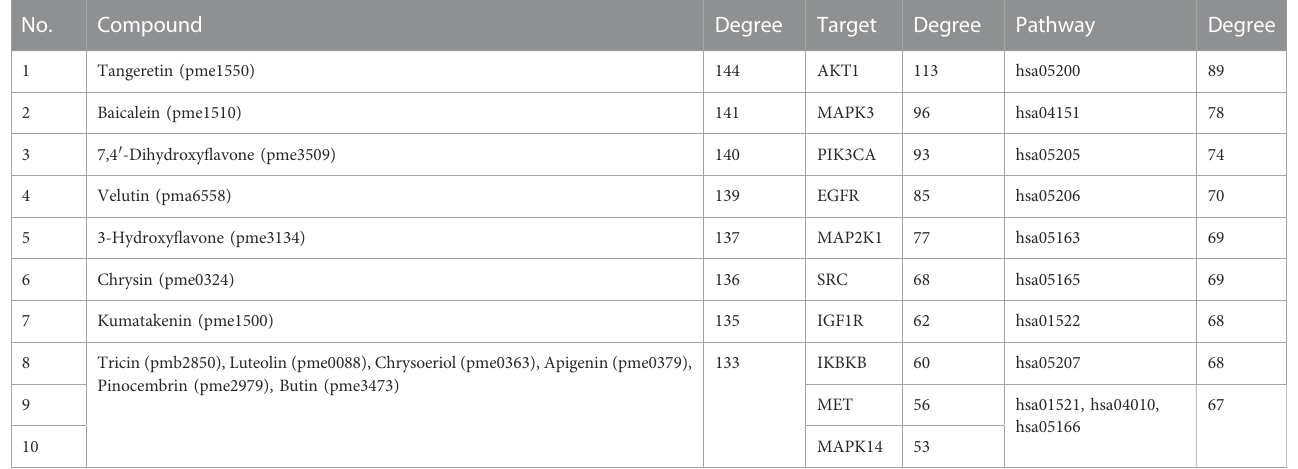
TABLE 1 The top ten active ingredients, targets, and pathways that affect the entire network with high median values of betweenness centrality and closeness centrality.